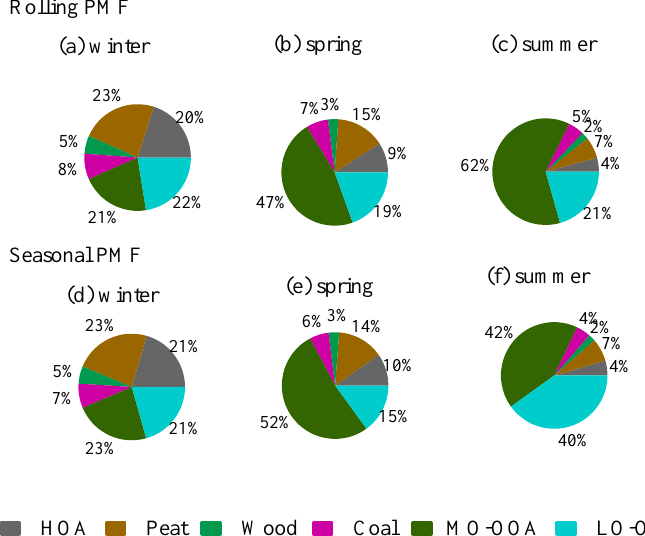
Figure 6. Comparison of the OA factor fractions in winter, spring, and summer apportioned by the rolling PMF ( a – c ) and seasonal PMF ( d – f ).